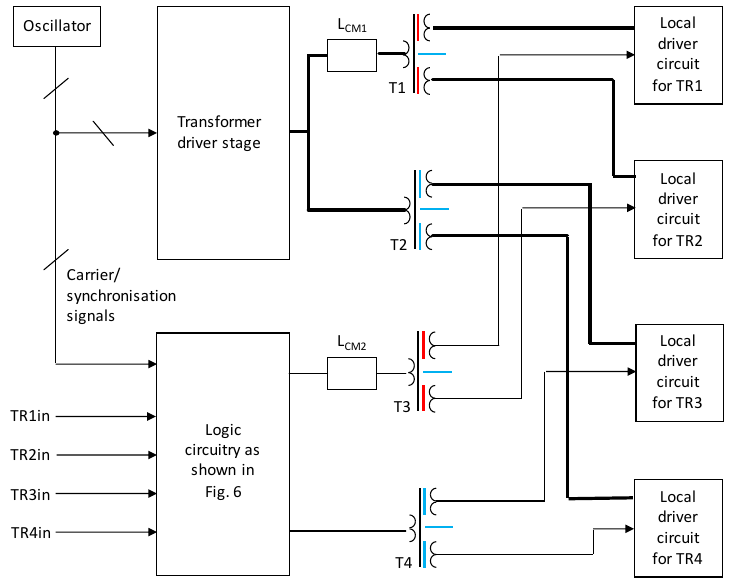
Figure 8. Block diagram of the proposed gate driver circuit.